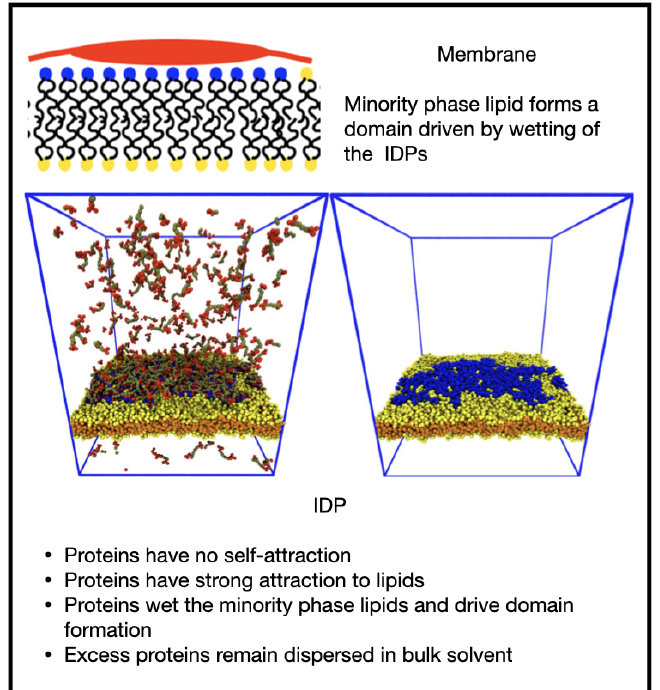
Figure 6. Increasing the IDP–membrane attraction in the absence of any IDP self-attraction leads to wetting of a domain formed of the minority phase lipids. Membranes 2022 , 12 , 17 Finally, increasing both affinities to 𝜀 (cid:3006)(cid:3006) = 𝜀 (cid:3006)(cid:3014) = 0.8 led to the formation of a bulk droplet of IDP and wetting of a single domain in the membrane. After diffusing for some time, the droplet adsorbed to the domain, but at the selected concentration, it protruded from the membrane, forming a membrane-associated dense phase. (Figure 7 and Supple- mentary Video SM4). The domain fluctuated around a circular shape, indicating the ex- istence of a fairly high line tension. Small numbers of majority phase lipid sometimes dif- fused through the domain as seen in the movie SM4.